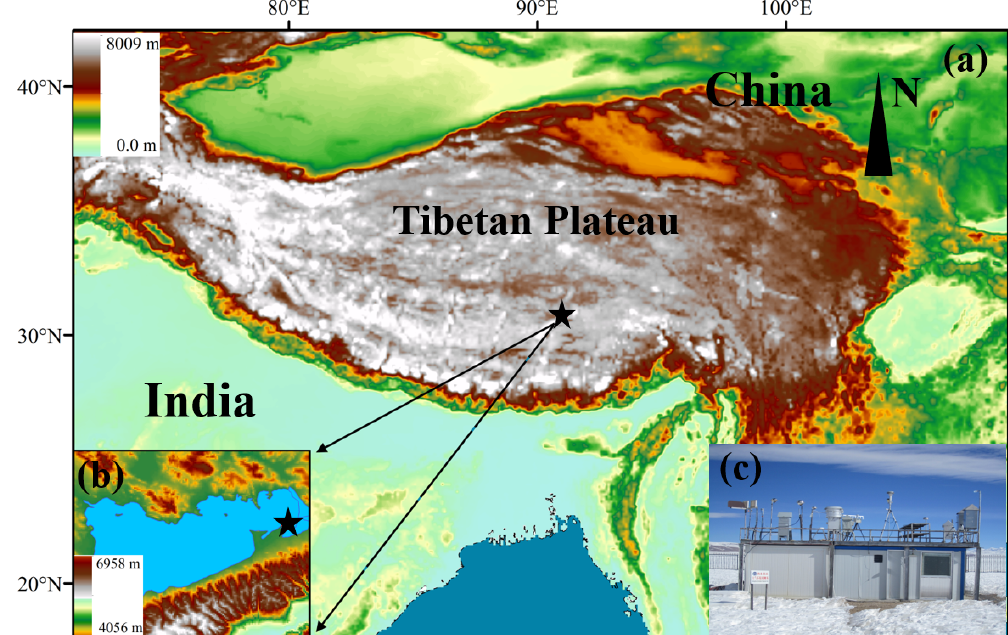
Figure 1. Location map for (a) the Tibetan Plateau, (b) the Nam Co station, colored according to altitude. (c) The appearance drawing of atmospheric environment observatory field of the Nam Co station (Yin et al.,